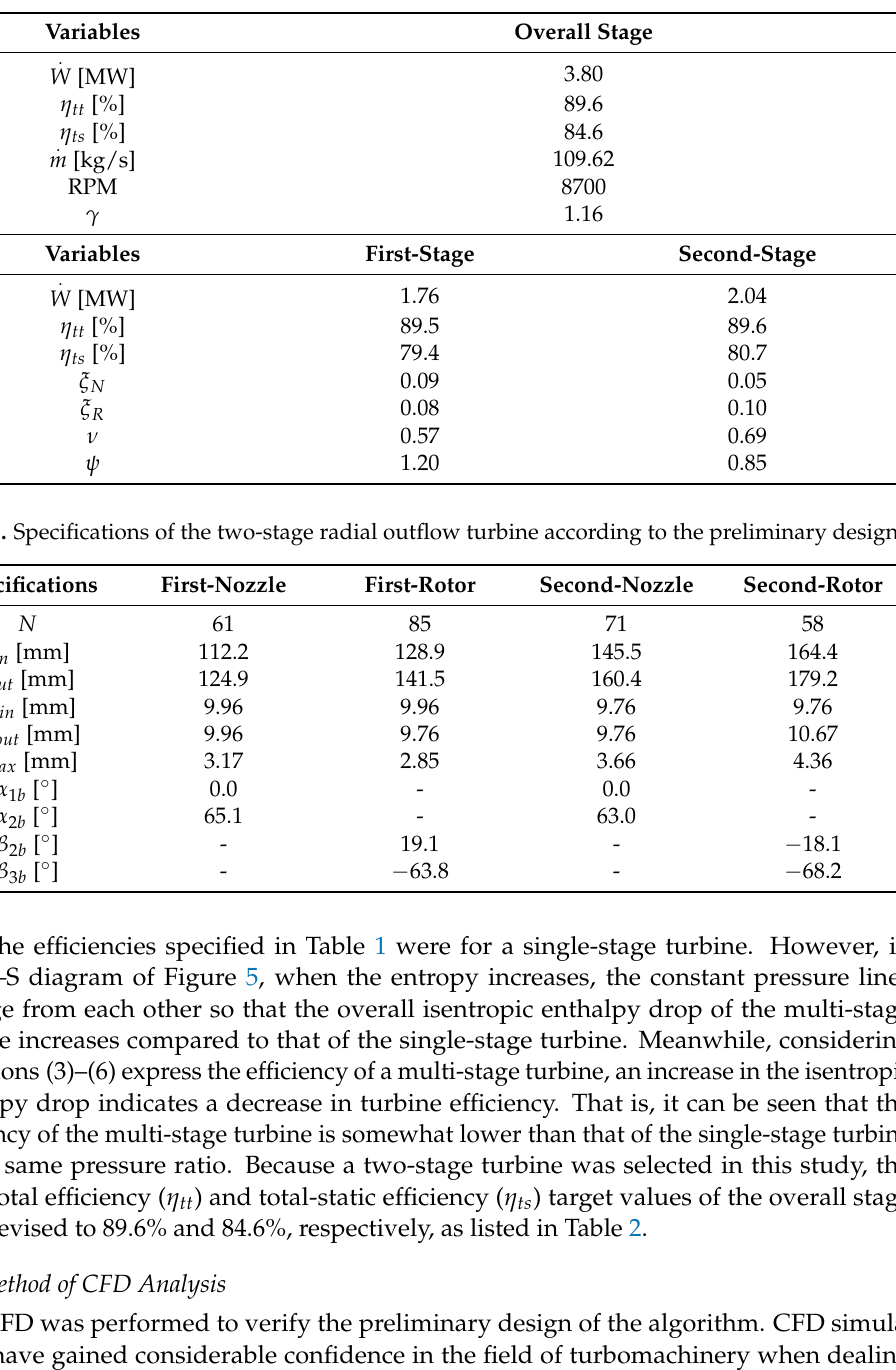
Table 2. Main results of the two-stage radial outflow turbine according to the preliminary design.